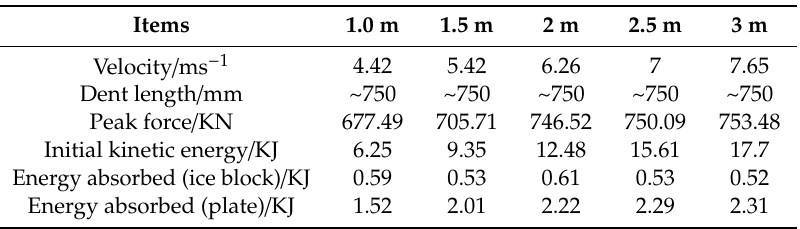
Table 4. Variation in drop parameters at di ff erent drop